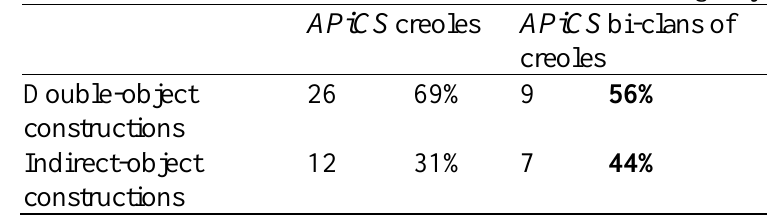
Table 4. Ditransitive constructions in creoles (exclusive marking